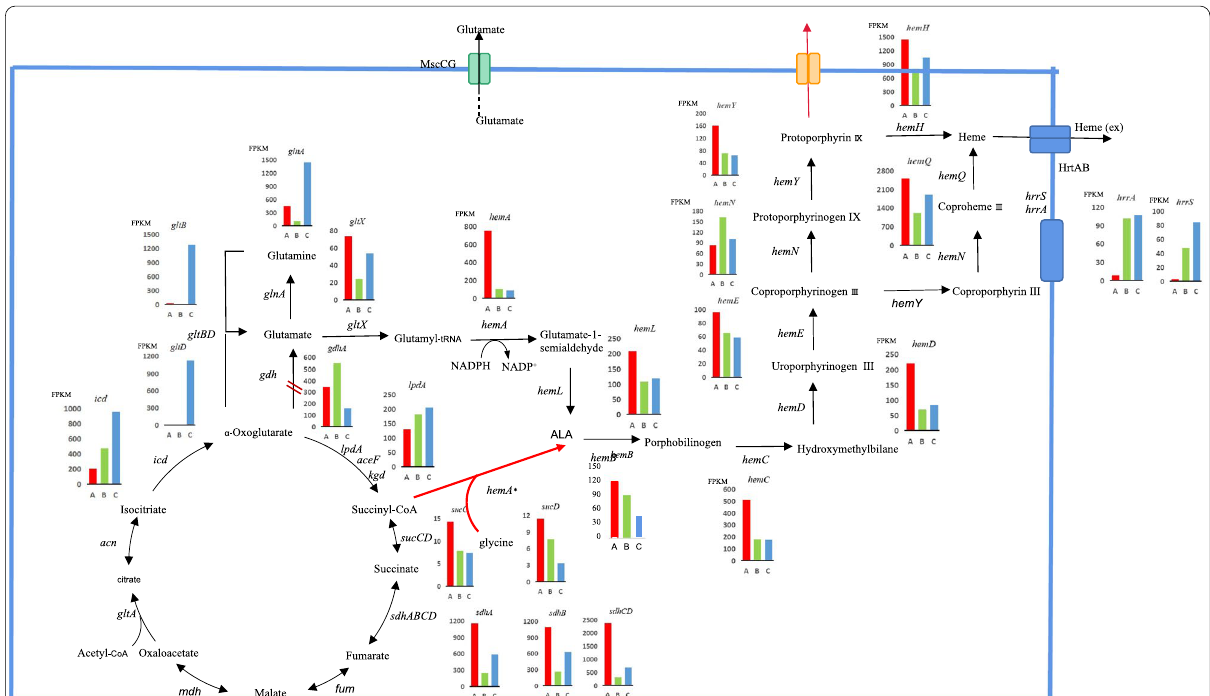
Fig. 4 Transcription profiles of key genes involved in TCA, C5, glutamate synthesis pathway and heme pathway in C. glutamicum F1-P, F1-A and